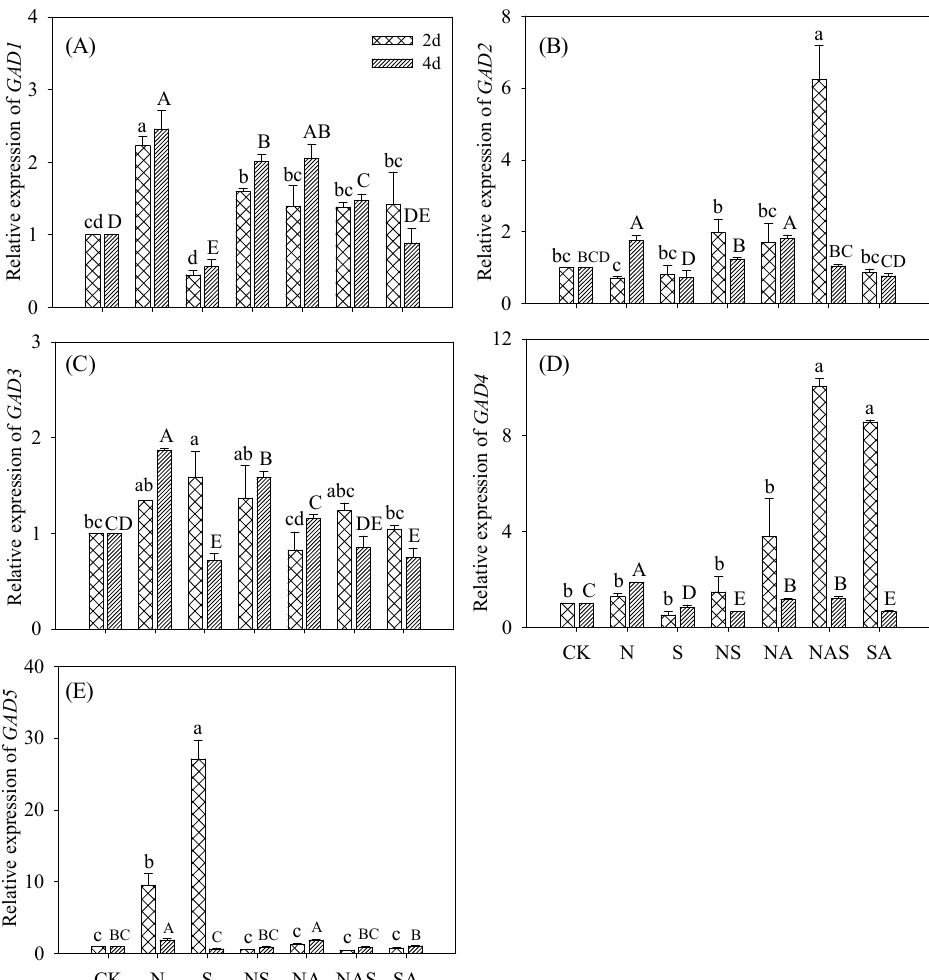
Figure 6. Changes of ( A ) GAD1 , ( B ) GAD2 , ( C ) GAD3, ( D ) GAD4 , and ( E ) GAD5 relative expression in germinating soybeans. Lowercase letters reflect the significance of differences in index among treatments of 2-day germinating soybeans and capital letters reflect the significance of differences in index among treatments of 4-day germinating soybeans ( p < 0.05). CK, Control; N, NaCl; S, Spd; NS, NaCl + Spd; NA, NaCl + AG; NAS, NaCl + AG + Spd; SA, Spd + AG; AG, Aminoguanidine.